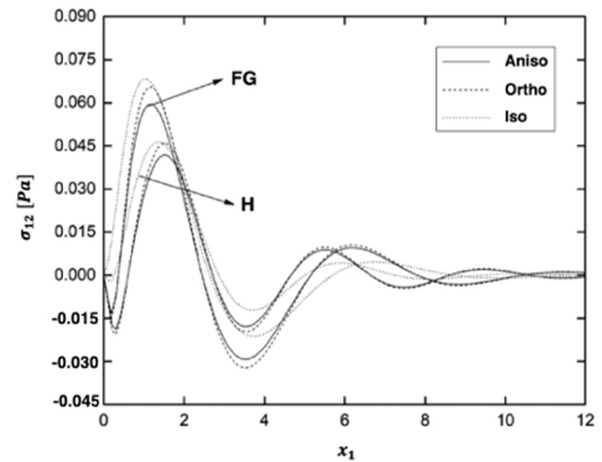
Figure 9. Variation of the thermal stress wave σ 12 along x 1 − axis in the functionally graded (FG) and homogeneous (H) fiber-reinforced plates for different materials.